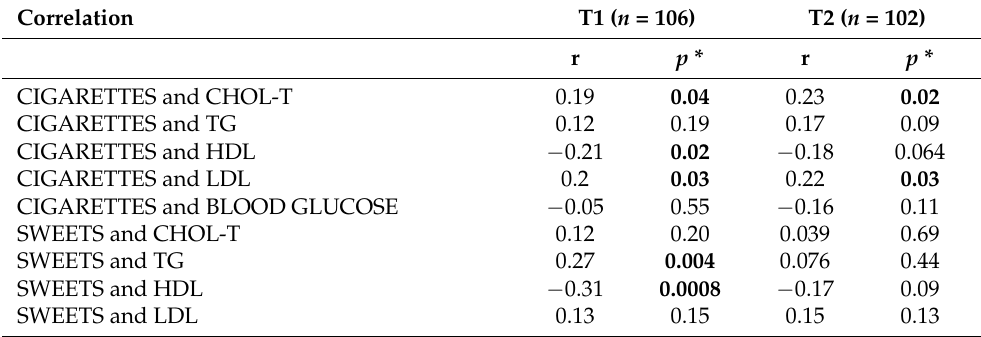
Table 2. Correlations between smoking, eating habits, physical activity and biochemical parameters at T1 and